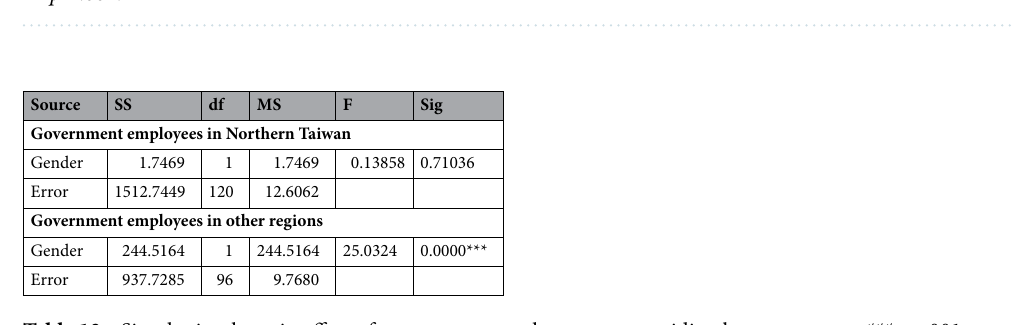
Table 13. Simple simple main effect of government employment on avoiding human contact. *** p < .001.